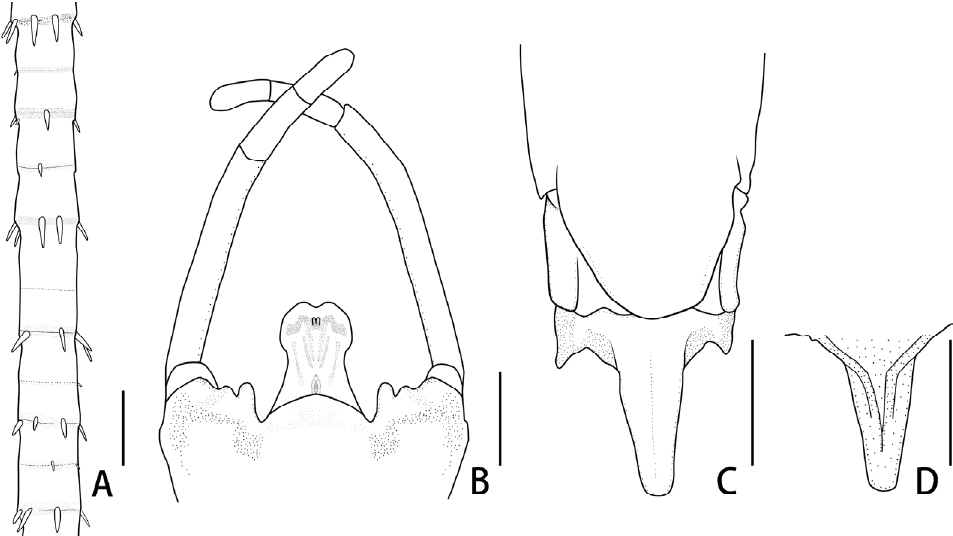
Figure 8. Nymphal and imaginal structures of Regulaneuria cingulata : ( A ) Whorls of spines of caudal filaments; ( B ) Genitalia (ventral view); ( C ) Subgenital and subanal plates of female imago (ventral view); ( D ) Subanal plate of female imago (dorsal view). Scale bars: ( A , B ) = 0.2 mm; ( C , D ) = 0.5 mm.